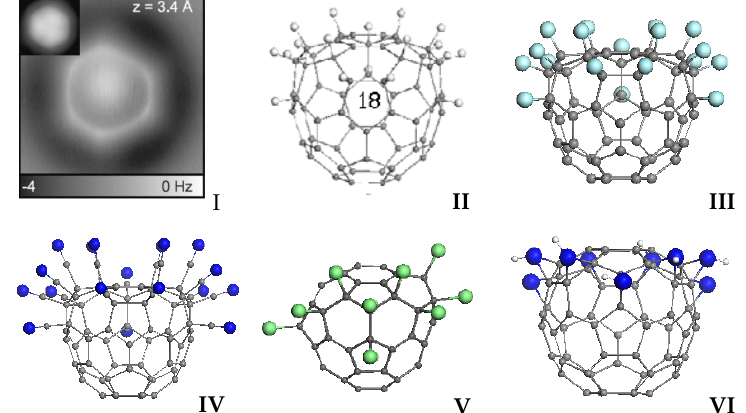
Figure 6. ( I ) STM image of C 60 on Cu(111) (left-up-corner insert) that reveals the orientation of C 60 , while the main image presents the constant-height AFM images of C 60 on Cu(111) obtained with a CO Figure 6 . tip (see text). ( II–VI ) Computational spin chemistry of fullerene C 60 . Monodentant polyderivatives C 60 H 18 ( II ), C 60 F 18 ( III ), C 60 (CN) 18 ( IV ), and C 60 Cl 18 ( V ) obtained at the 18th step of the successive polyderivatization following N DA algorithm; the same for bidentant poliderivative C 60 (NH) 9 ( VI ) at the ninth step. See detailed discussion in